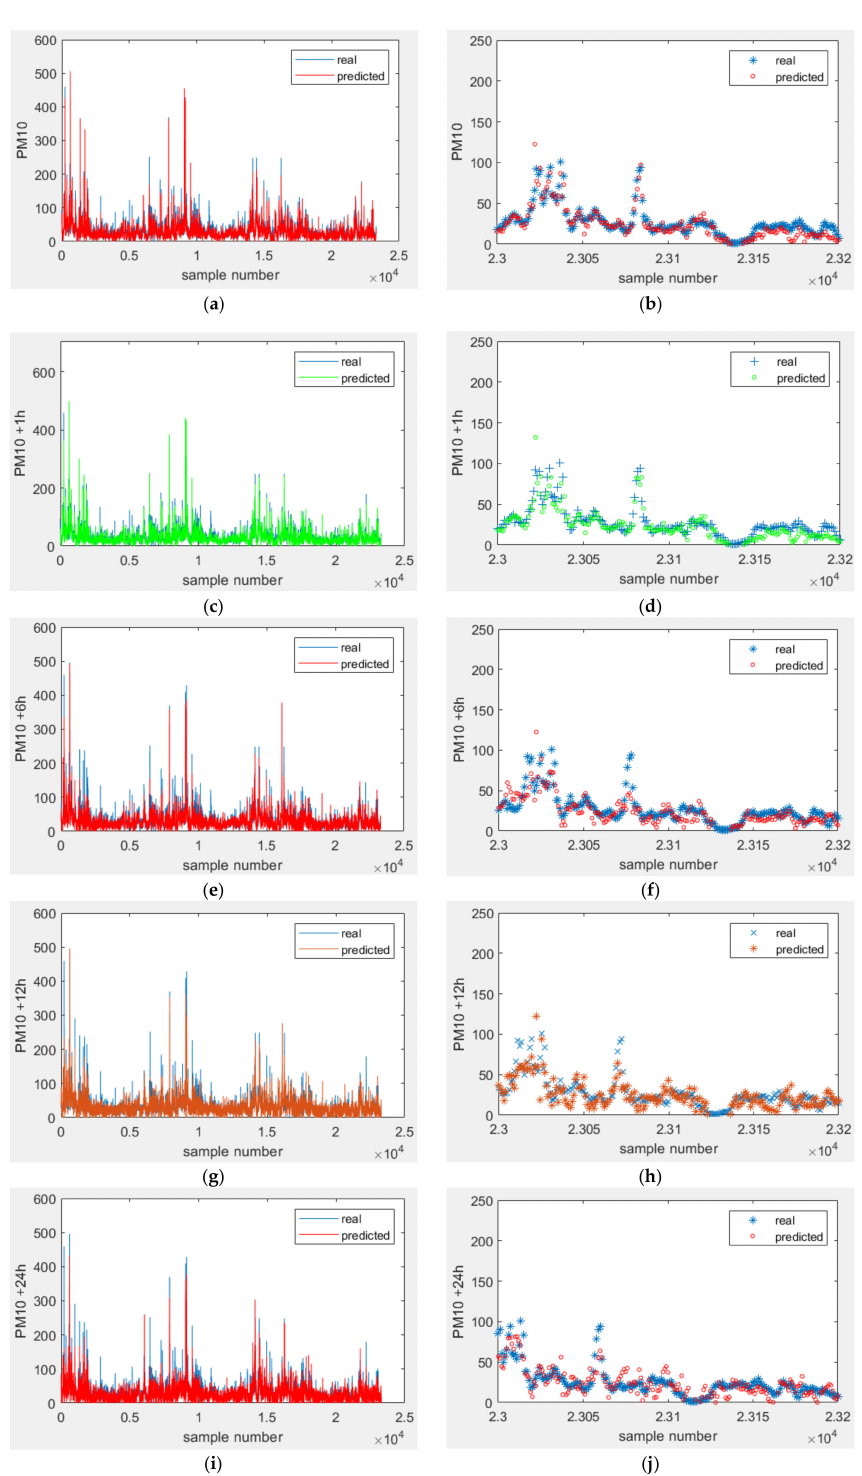
Figure 15. Comparison of actual data and the results obtained by prediction at successive time points: ( a ) PM10 level, ( c ) PM10 level after 1 h, ( e ) PM10 level after 6 h, ( g ) PM10 level after 12 h and ( i ) PM10 level after 24 h; and results for sample numbers ranging from 23,000 to 23,200: ( b ) PM10 level, ( d ) PM10 level after 1 h, ( f ) PM10 level after 6 h, ( h ) PM10 level after 12 h and ( j ) PM10 level after 24